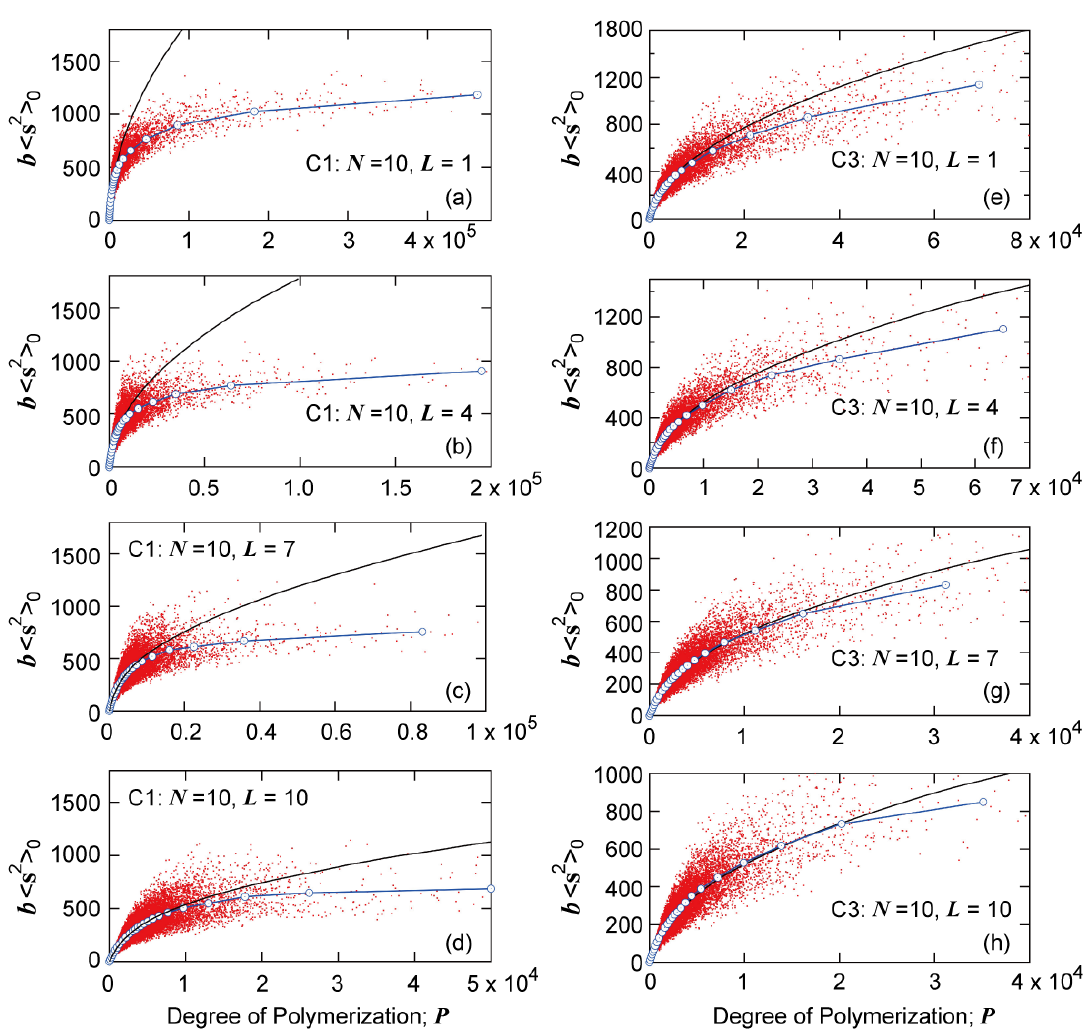
Figure 15. Relationship between the mean-square radius of gyration <s 2 > 0 and degree of polymerization P of the polymer molecules formed in various reactor placements with N = 10: ( a ) C1, L = 1; ( b ) C1, L = 4; ( c ) C1, L = 7; ( d ) C1, L = 10; ( e ) C3, L = 1; ( f ) C3, L = 4; ( g ) C3, L = 7; and ( h ) C3, L = 10. The black curve shows the relationship for random branched polymers calculated from Equation